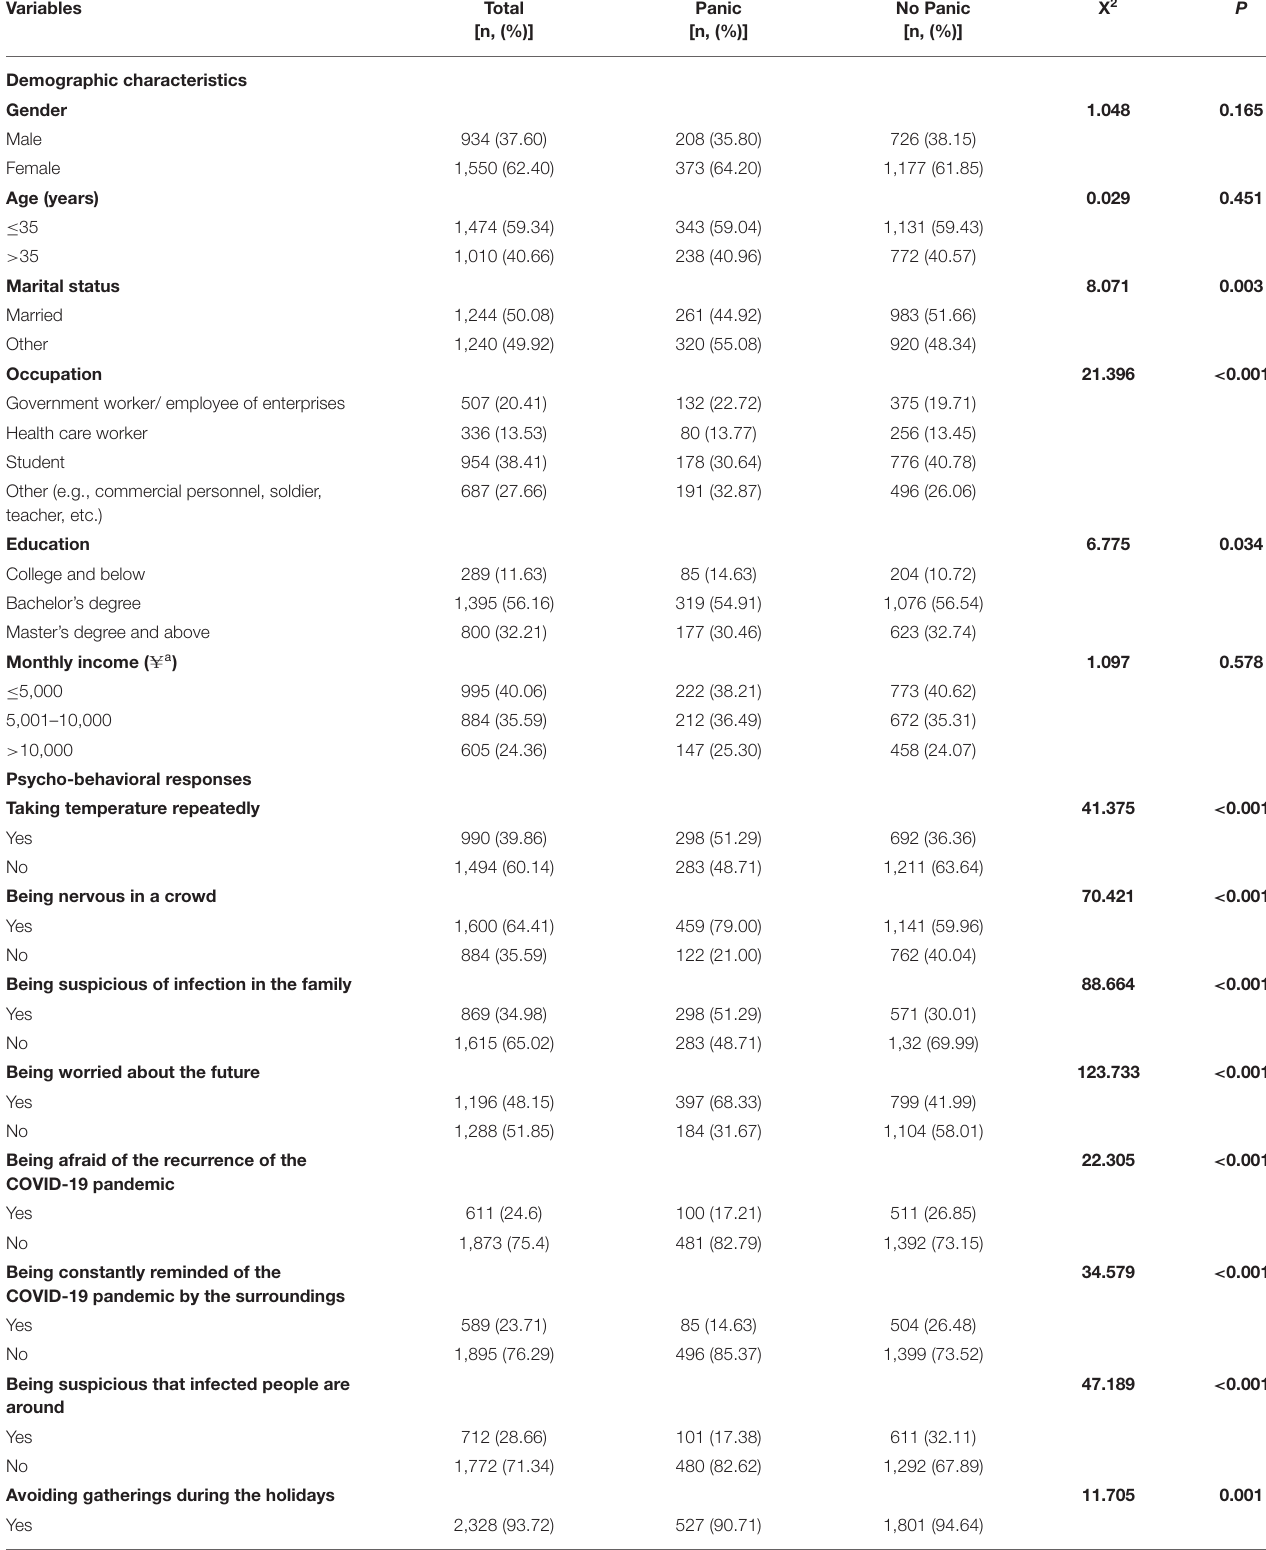
TABLE 1 | The distribution of public panic ( N =